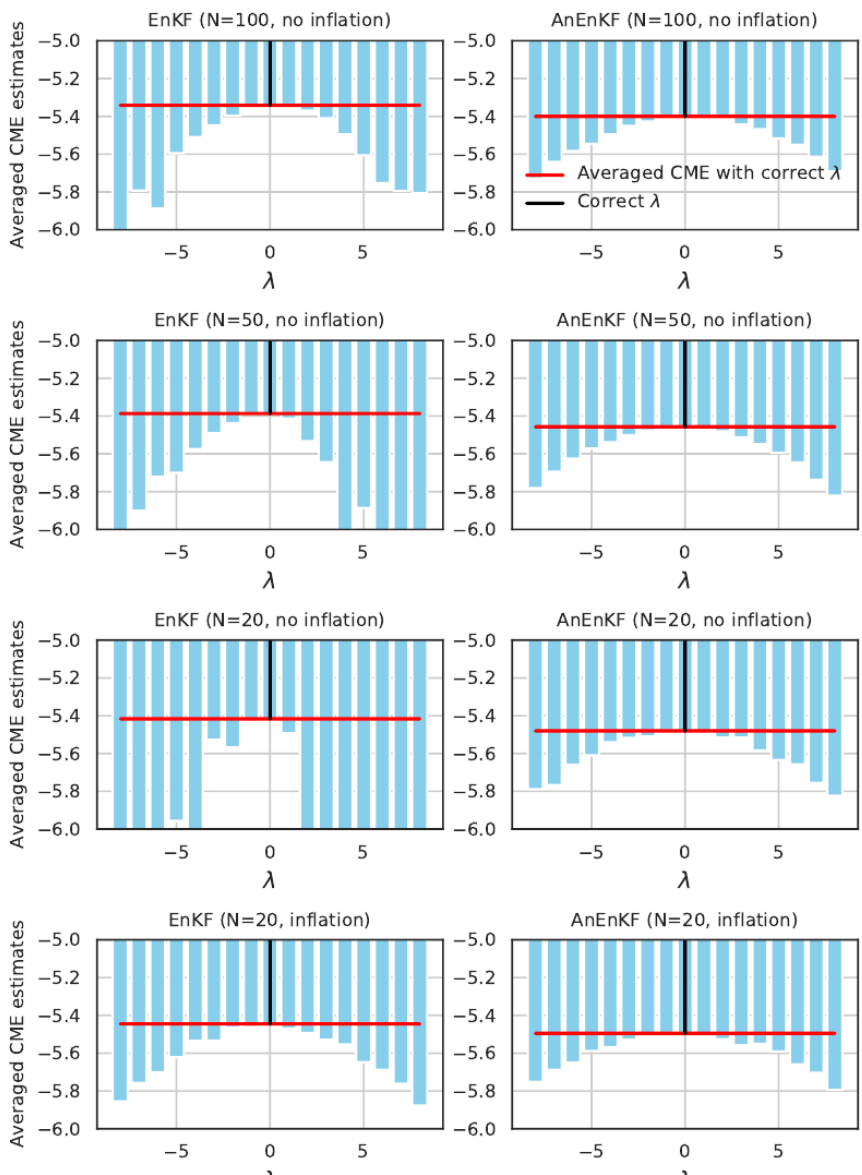
Figure 3. Time-averaged CME as a function of the parameter λ used to generate the incorrect model for the EnKF (left) and AnEnKF (right) approaches using different number of members N (rows). Adaptive inflation is used only for the results in the bottom row. The red line indicates the time-averaged CME for the correct model ( λ =